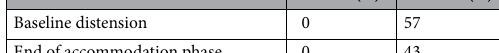
Condition Control (%) Stressed